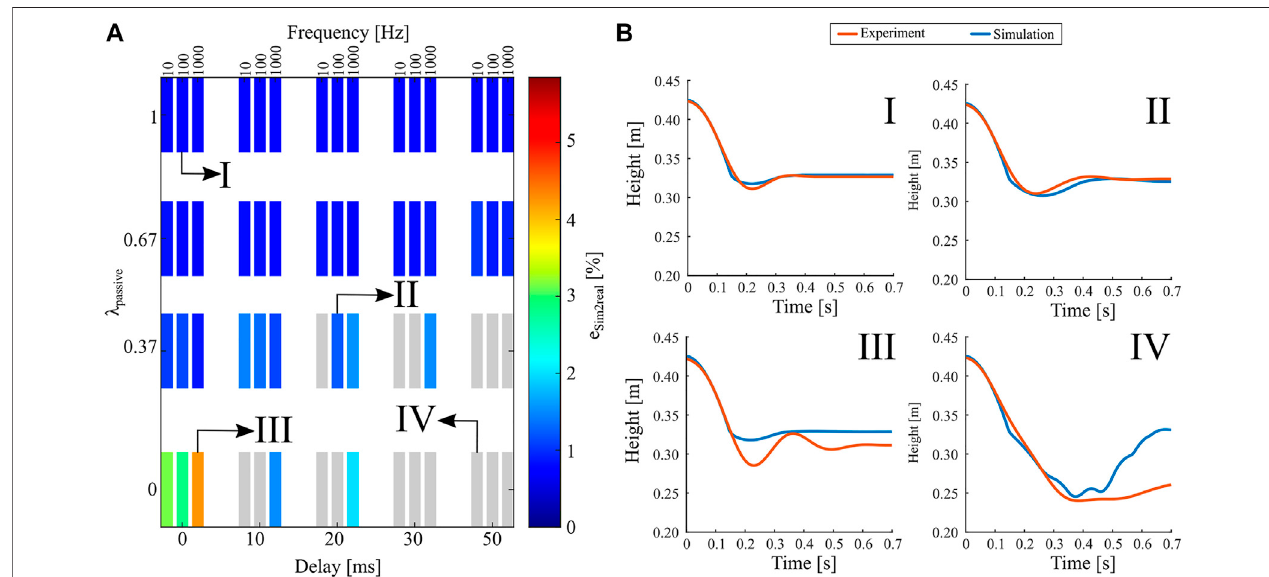
FIGURE 9 | Results comparing computer simulations and hardware experiments, as root-mean-square error of the instantaneous hip height normalized by the initialleglength. (A) Goodsimilaritiesareshownascoloreddatapatches.Greydatapatchesindicateunsuccessfuldropexperiments,violatingsettlingtimeor fi nalheight criteria. (B) Hip trajectories. (I – III) Successful landings with short settling times and suf fi cient settling hip heights. (IV) An example of an unsuccessful landing in simulation and hardware.